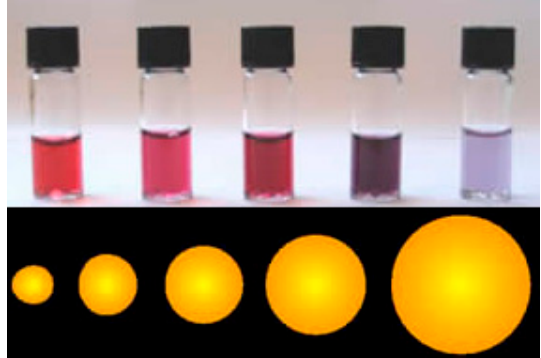
Figure 6. Color differences caused by variations in size of AuNPs. Figure taken from Wikipedia on 6 Figure 6. Color di ff erences caused by variations in size of AuNPs. Figure taken from Wikipedia